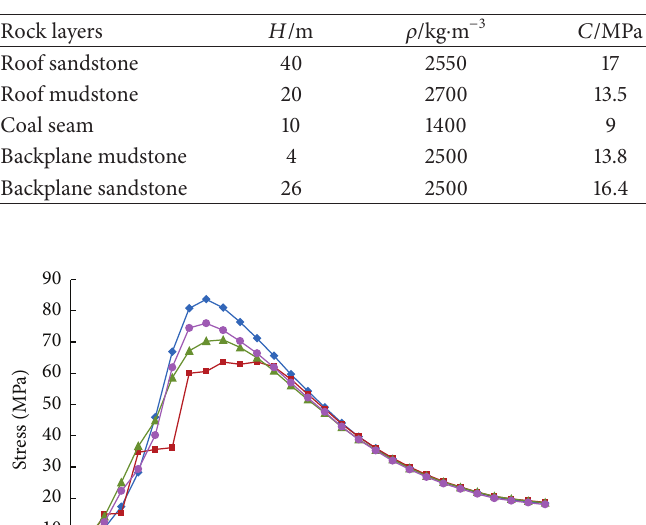
Table 4: The physical and mechanics properties of rock layers in numerical simulation.